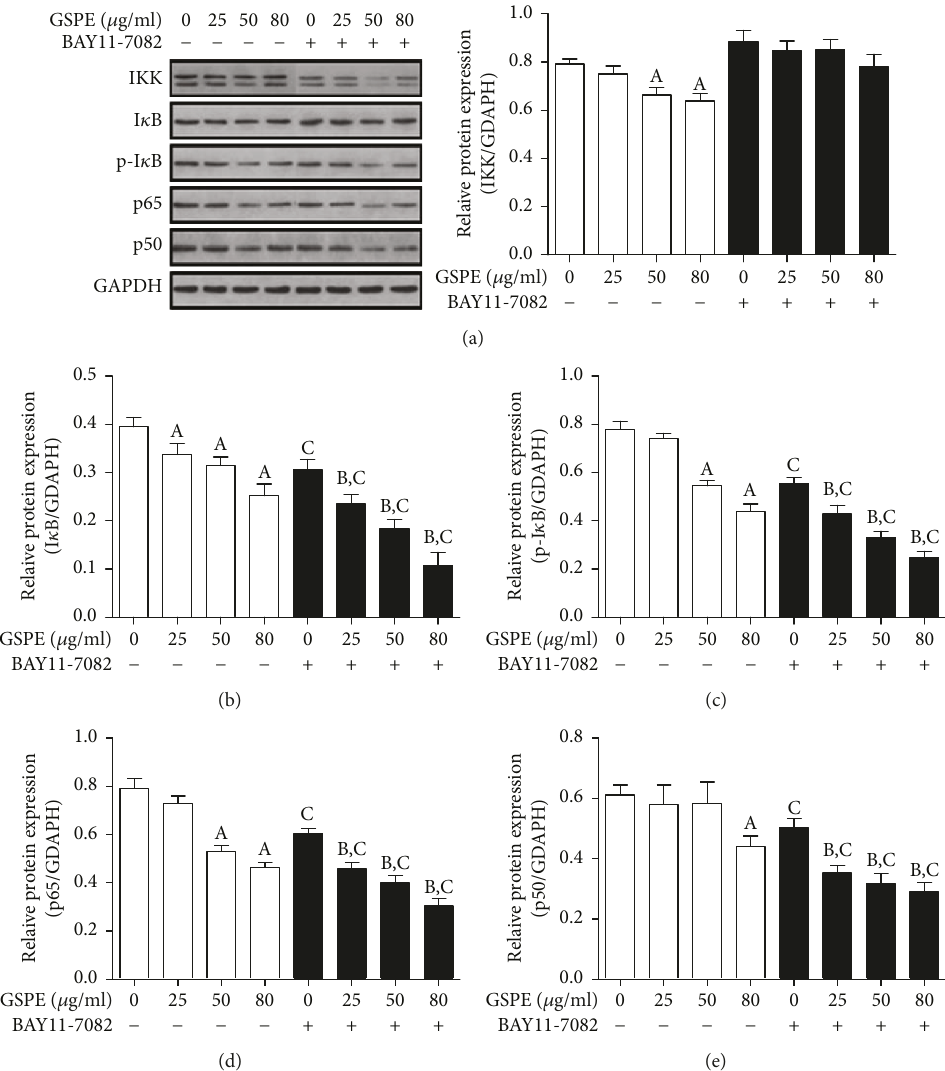
Figure 9: The e ff ects of GSPE and BAY11-7082 on the expression of IKK, I κ B, p50, and p65 protein ECA109 cells. (a) The inhibition of the IKK protein expression by GSPE (0 – 80 μ g/mL) and BAY11-7082 (10 μ mol/L). (b) The inhibition of I κ B protein expression by GSPE (0 – 80 μ g/mL) and BAY11-7082 (10 μ mol/L). (c) The inhibition of p-I κ B protein expression by GSPE (0 – 80 μ g/mL) and BAY11-7082 (10 μ mol/L). (d) The inhibition of p65 protein expression by GSPE (0 – 80 μ g/mL) and BAY11-7082 (10 μ mol/L). (e) The inhibition of p50 protein expression by GSPE (0 – 80 μ g/mL) and BAY11-7082 (10 μ mol/L). The mean ± SD of three groups of independent samples are shown in each column. A P < 0 05 compared with the GSPE 0, BAY11-7082 – ; B P < 0 05 compared with the GSPE 0, BAY11-7082+ group; C P < 0 05 compared with the BAY11-7082